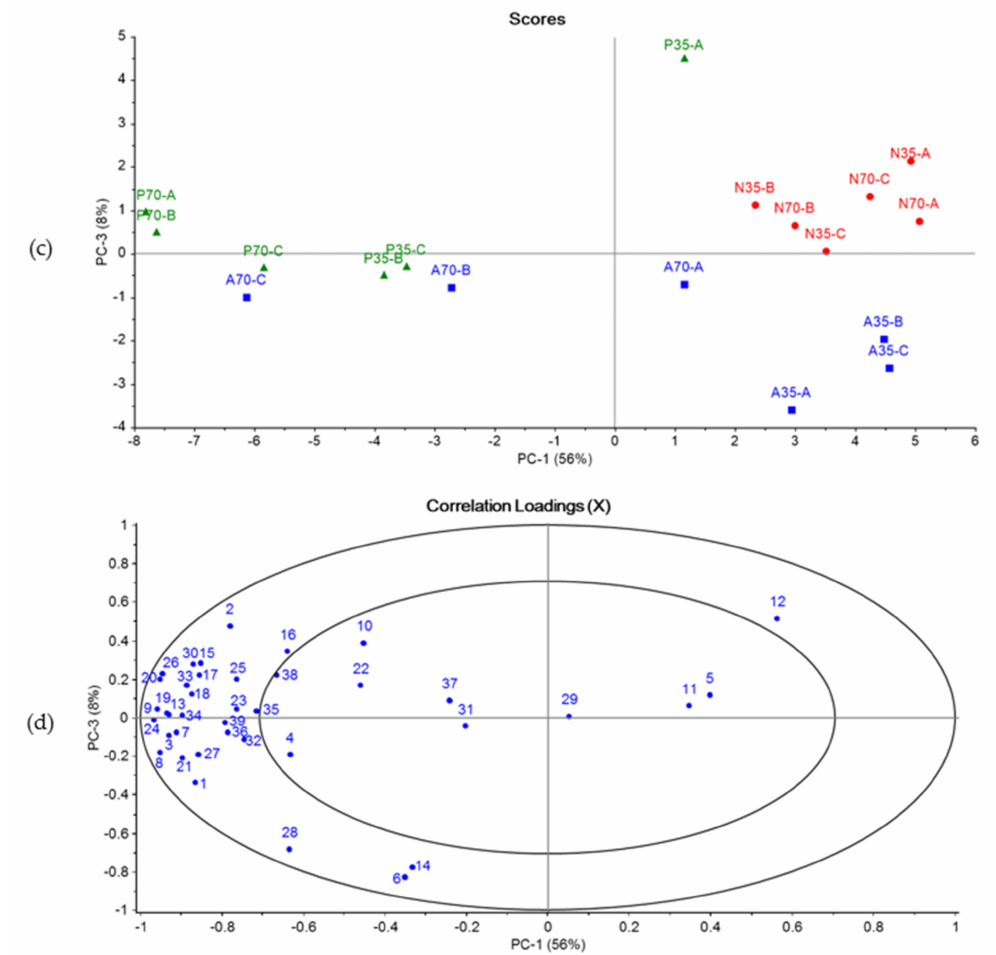
Figure A1. Principal component analysis (PCA) of volatile data from enzymatically extracted oils from whole Baltic herring. The samples are A: Alcalase (blue), N: Neutrase (red) and P: Protamex (green). The samples are also marked according to their extraction times of 35 or 70 min. ( a ) Scores plot of Principal Components (PC) 1 and 2; ( b ) correlation loadings of PC1 and PC2; ( c ) scores plot of PC1 and PC3 and ( d ) correlation loadings of PC1 and PC3. The numbered volatiles are (1) acetaldehyde, (2) 2-propenal, (3) propanal, (4) butanal, (5) 2,3-butanedione, (6) unknown 1, (7) formic acid, (8) 1,3- butanediol, (9) acetic acid, (10) 3-methylbutanal, (11) heptane, (12) 2-methylbutanal, (13) ( Z )-2-butenal, (14) 2-ethylfuran, (15) 1-penten-3-one, (16) 1-penten-3-ol, (17) 2,3-pentanedione, (18) cyclopentanol, (19) propanoic acid, (20) ( E )-2-pentenal, (21) hexanal, (22) 2-methyl-4-pentenal, (23) 3-hexanol, (24) 2,4- hexadien-1-ol, (25) ( E )-2-hexenal, (26) heptanal, (27) ( E , E )-2,4-hexadienal, (28) unknown 2, (29) 2- pentylfuran, (30) ( Z )-2-heptenal, (31) trans-2-(2-pentenyl)furan, (32) octanal, (33) hexanoic acid, (34) ( E , Z )-2,4-heptadienal, (35) ( E , E )-2,4-heptadienal, (36) ( E , E )-3,5-octadien-2-one, (37) 2-nonanone, (38) nonanal, (39) 5-ethyl-2(5H)-furanone, (40) ( E , E )-3,5-Octadien-2-one and (41) nonanoic